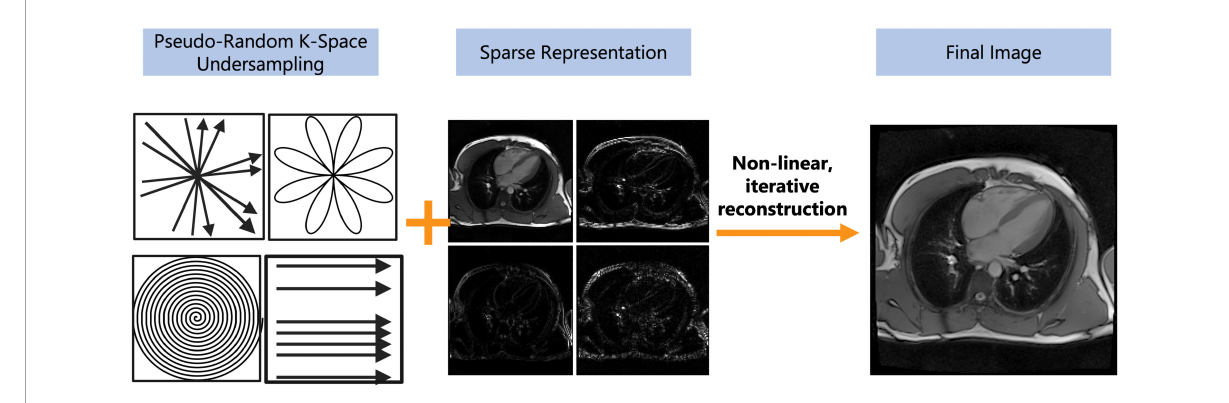
FIGURE4 Depiction of the compressed sensing concept. Compressed sensing requires both a pseudo-random undersampling of k-space and for a sparse representation of the image in some transform domain (e.g., wavelet, finite difference, etc.). The pseudo-random sampling of k-space can be achieved with a variety of sampling trajectories such as radial, rosette, spiral, or cartesian. The under-sampled data undergoes a non-linear, iterative reconstruction to recover image integrity from the aliased image. The pseudo-random sampling of k-space allows undersampling artifacts to appear as noise and can be removed by thresholding in a sparse domain. The final image may have reduced image quality but should still be